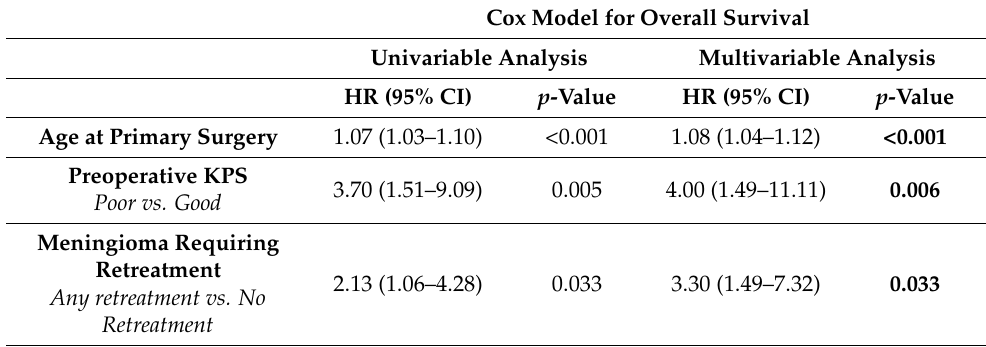
Table 3. Univariable and multivariable Cox analyses for overall survival and retreatment-free